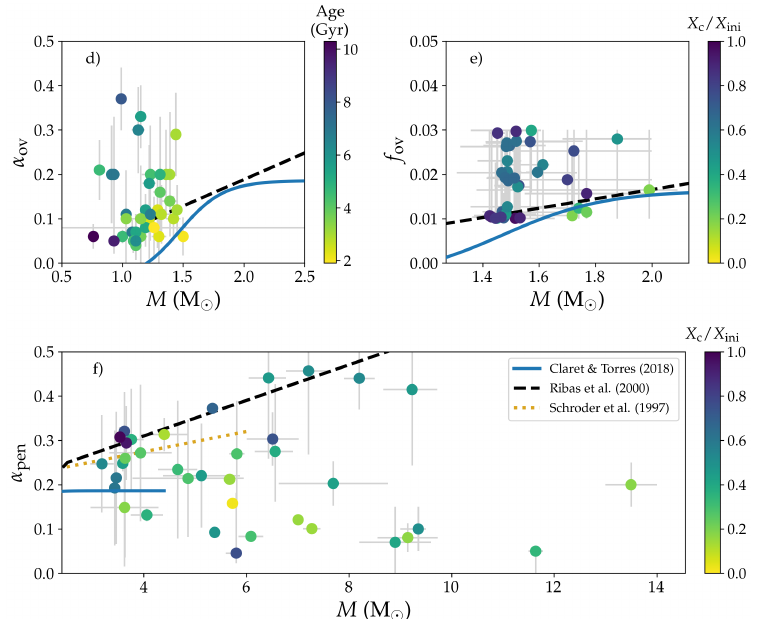
Figure 12. Asteroseismically derived CBM parameters available in the literature for 154 pulsating α pen main-sequence stars. To combine the data from all sources in panel ( a – f ), we assumed α ov ≈ α pen . Panels ( b – d ) show sub-samples of the stars from panel ( a ), where an ensemble and 11.36 f ov ≈ study was carried out using the same stellar structure and evolution code and modeling method- ology [73,315–317]. In panel ( f ), only M 3M stars from panel ( a ) with a known X c / X ini value ≥ (cid:12) are shown. For stars without estimated errors on the initial mass and CBM parameter, we adopt the average fractional errors from the sample with error estimates. Figure made by the authors using data from the following sources: